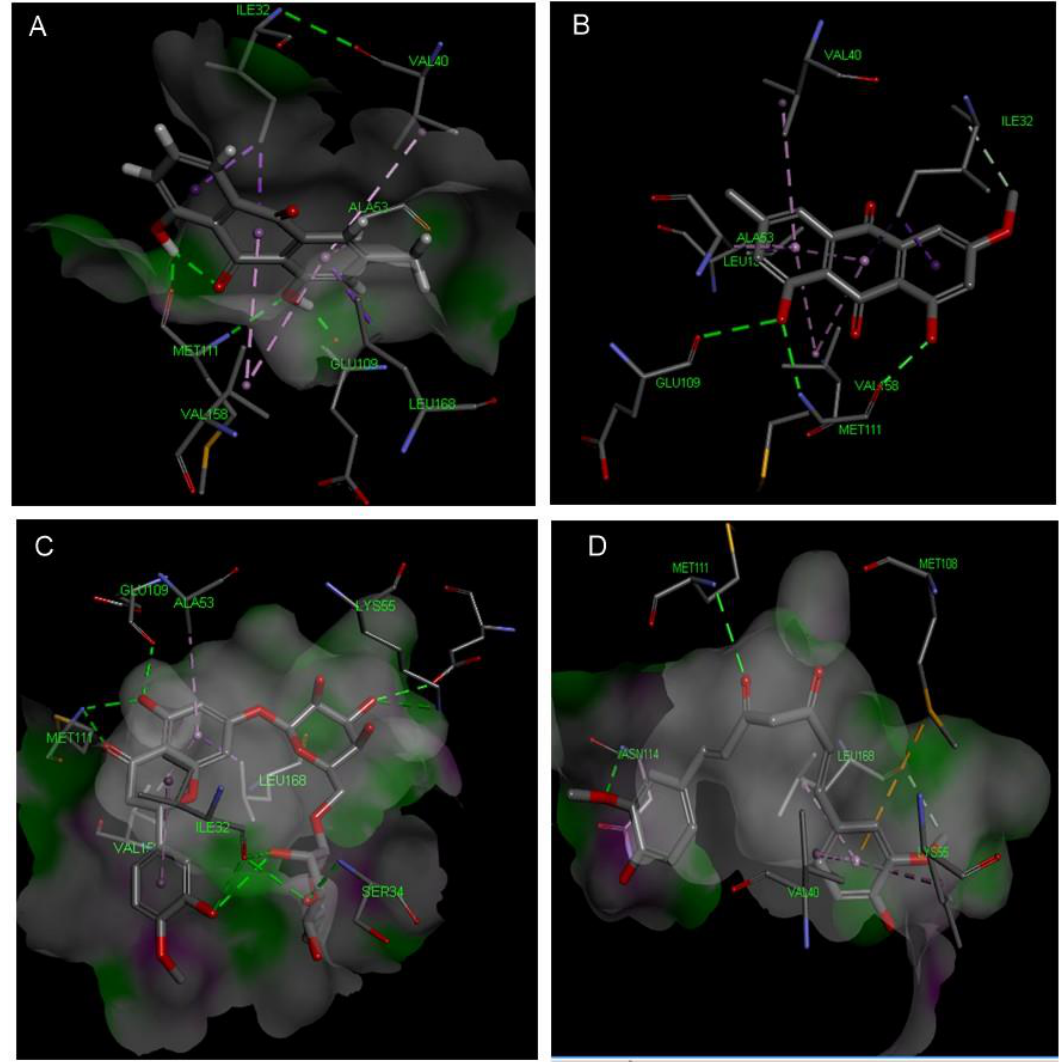
Figure 8. Molecular interactions of chrysophanol ( A ), physcion ( B ), hesperidin ( C ) and curcumin ( D ) with JNK MAPK (PDB ID: 1UKI).